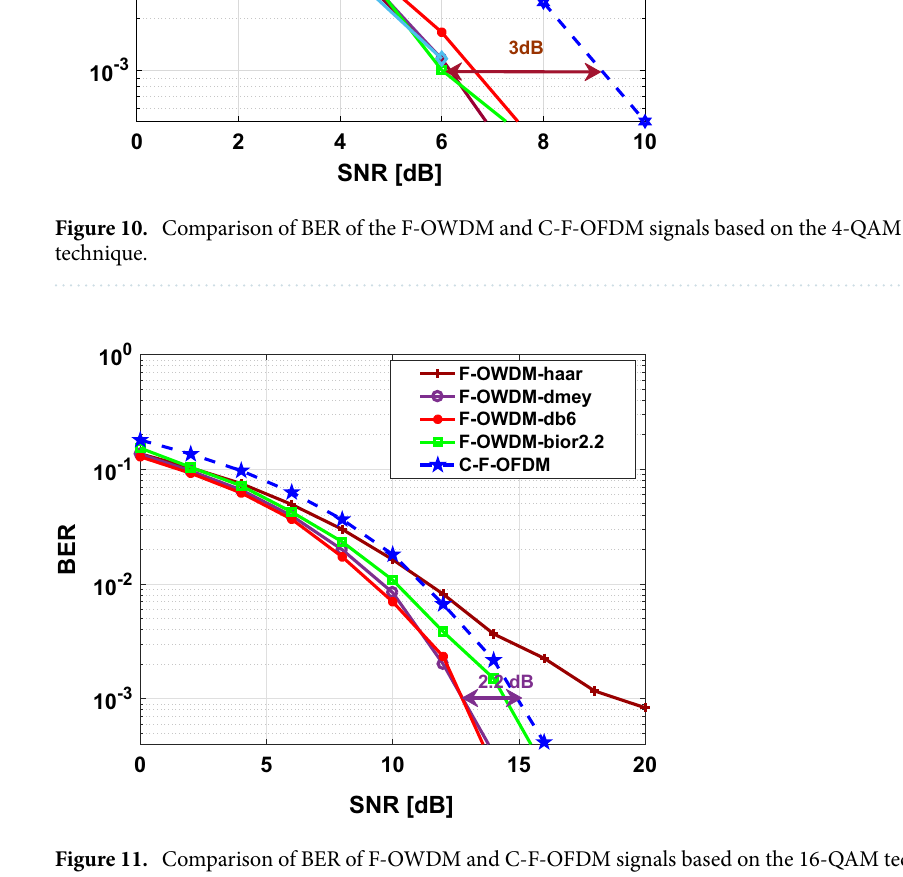
Figure 11. Comparison of BER of F-OWDM and C-F-OFDM signals based on the 16-QAM